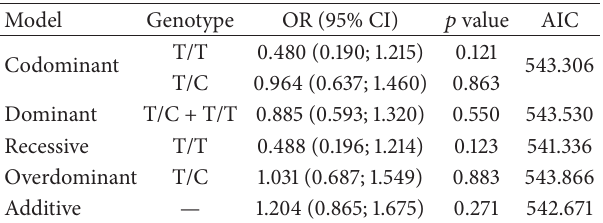
Table 7: Binomial logistic regression analysis of the CYP4F2 (1347C > T; V433M) rs2108622 in the patients with eAMD and in the control group.